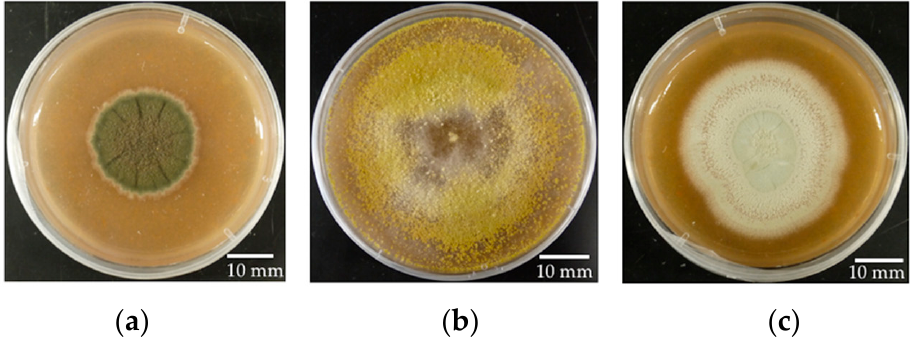
Figure 1. Selected strains of endophytic fungi. ( a ) Cladosporium tenuissimum SK2012; ( b ) Trichoderma sp. NM2012; ( c ) Penicillium citrinum 0079.